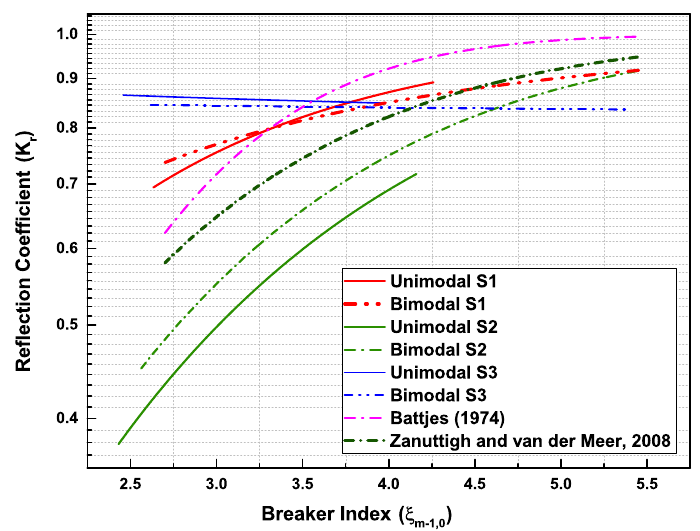
Figure 5. Variations of the reflection coefficient K r with breaker index ξ m − 1,0 across three different